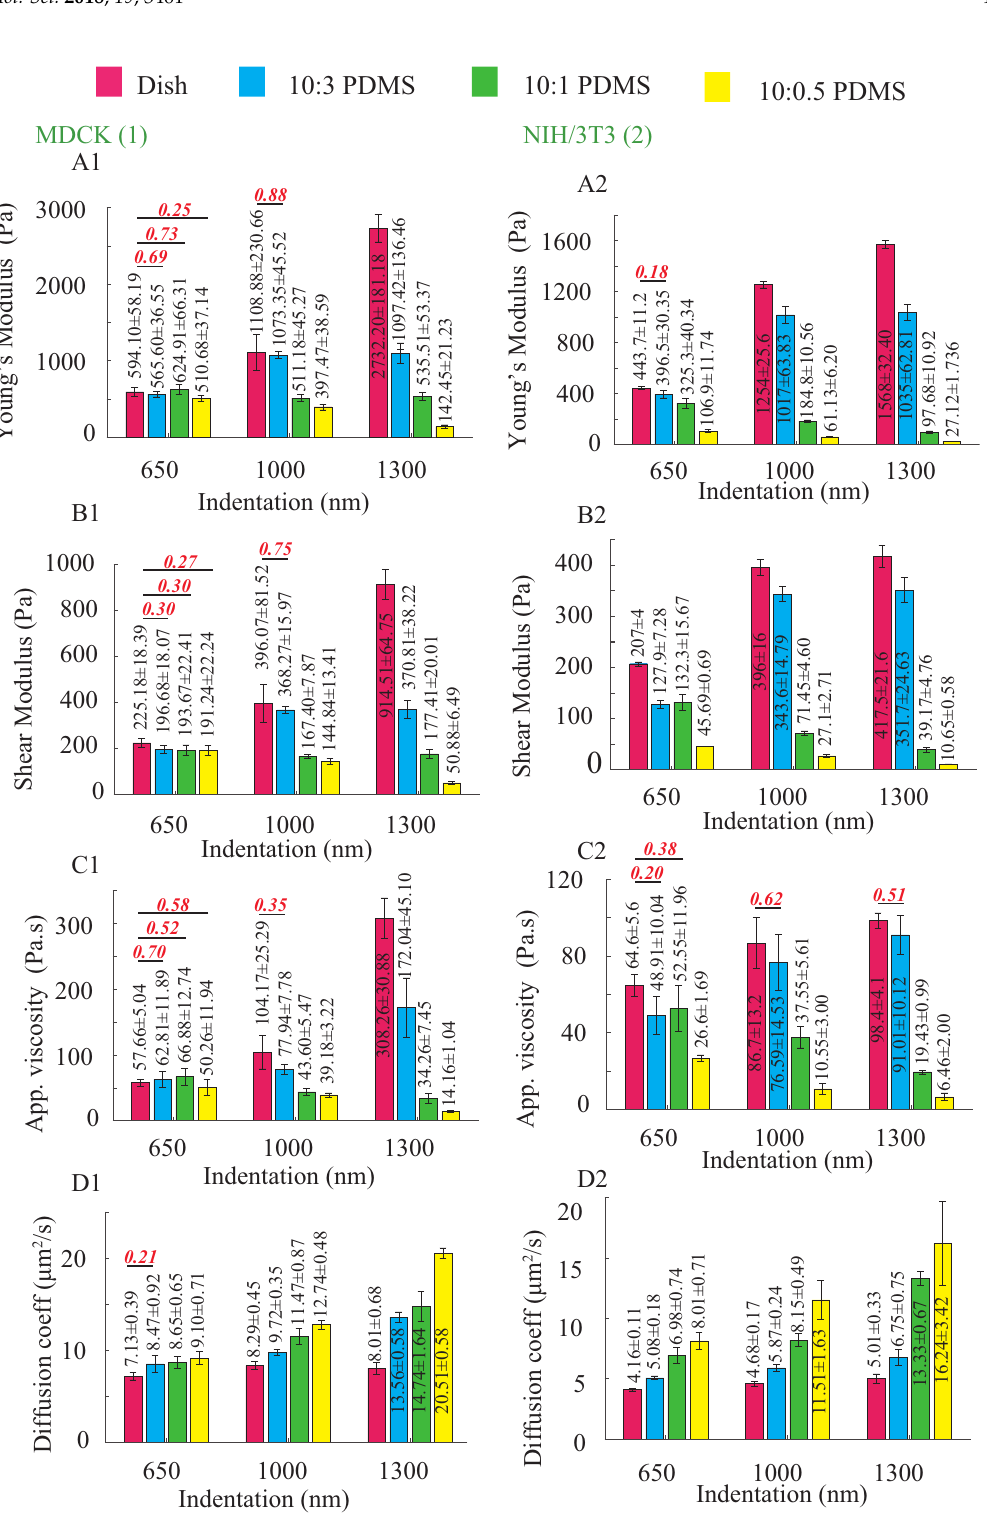
Figure 1. The nonlinear cellular: ( A1 , A2 ) Young’s modulus; ( B1 , B2 ) shear modulus; ( C1 , C2 ) apparent viscosity; and ( D1 , D2 ) diffusion coefficient of MDCK and NIH/3T3 cells seeded on different substrate, respectively, quantified at different indentation depths at the indenting velocity of 20 µ m/s. The AFM measurements were performed on six different cells at each indentation depth and the error bars represent the standard errors. n = 6. Student’s t -test was performed to analyze the statistical difference: for each indentation, data were compared with respect to the ones measured on the dish (control) at the same indentation; and for each substrate, the data measured at the minimum indentation (650 nm) for that substrate were chosen as control. A p < 0.05 was yielded for each comparison, unless otherwise denoted in the figure (with p values in red bold italic